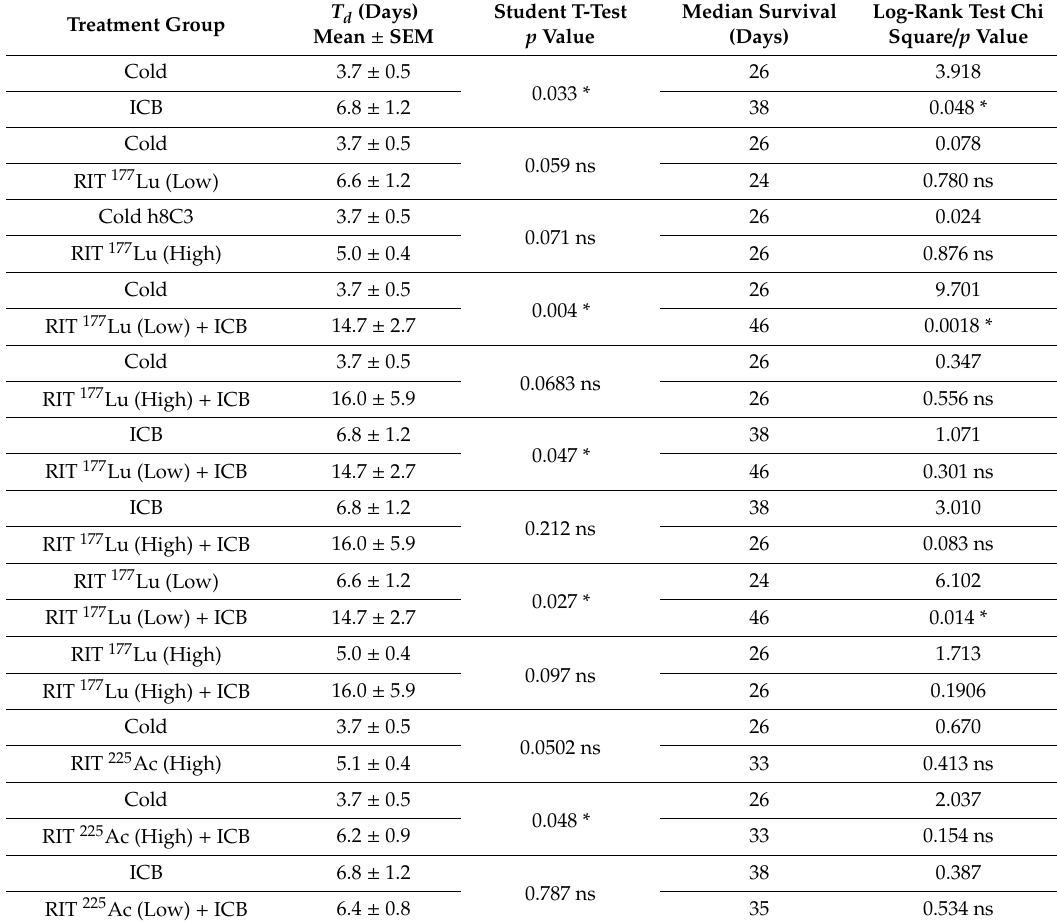
Table 1. Tumor doubling time (T d ) and median